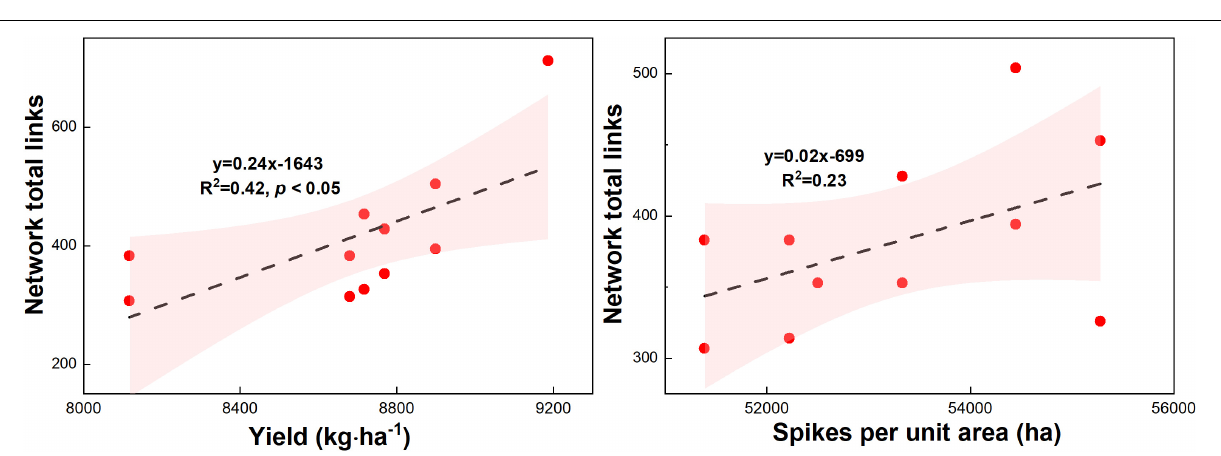
FIGURE 6 | Overview of bacterial networks in the bulk soil at the maize silking stage under different N fertilizer treatments (including CT, U, S, SU3, SU5, and SU7), with node size proportional to node connectivity. Node color represents various phylogenetic phyla.